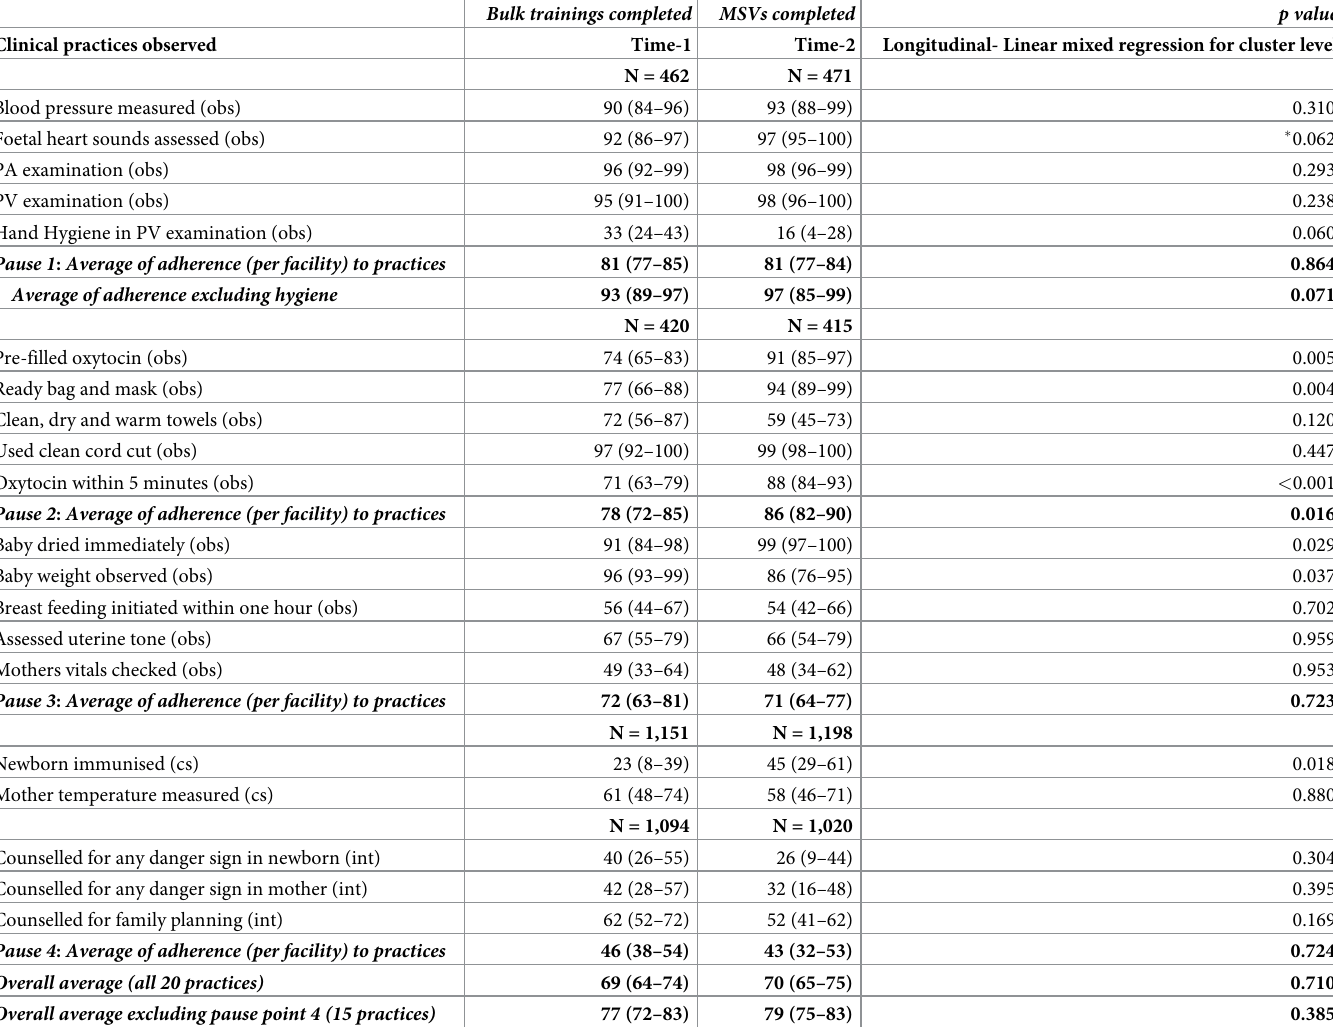
Table 2. Cluster level average adherence for each practice, pause points and overall, over